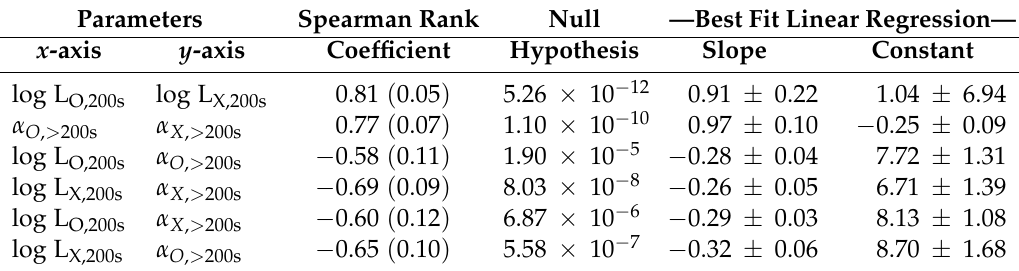
Table 1. For each pair of parameters examined, this table provides the Spearman rank correlation coefficient with its associated null hypothesis; the slope and constant values provided by the best fit linear regression. For comparison with our Monte Carlo simulations in Section 3, we also provide the 1 σ error of the Spearman rank coefficient (Adapted from Table 2 in